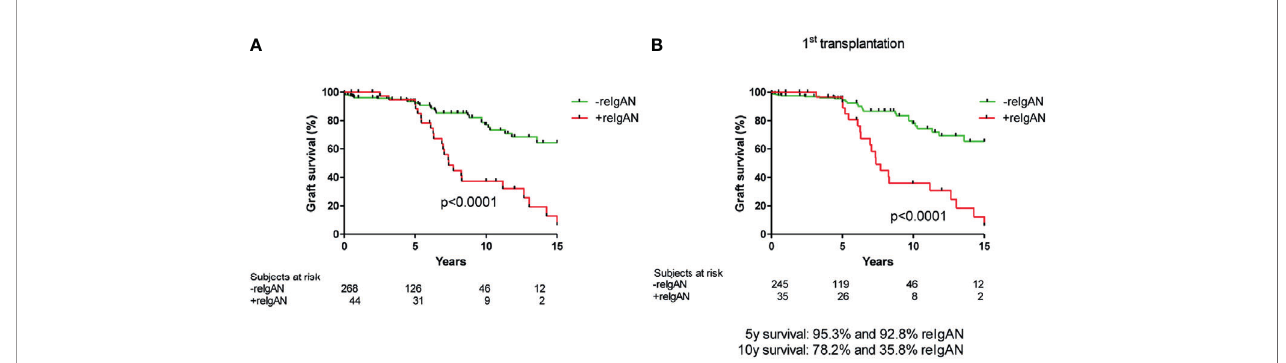
FIGURE 1 | Death-censored graft survival in patients with/without histological recurrence of IgAN in (A) total cohort (log rank p value p < 0.0001) and (B) only in recipients who received their fi rst graft (log rank p value p < 0.0001).